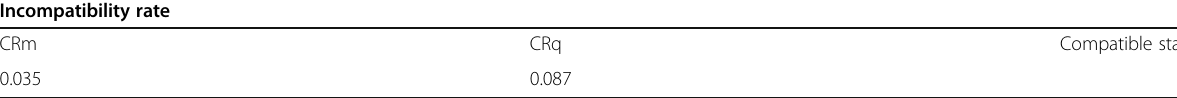
Table 2 Studying the compatibility of the judgments in determining the coefficients of major indices using MATLAB